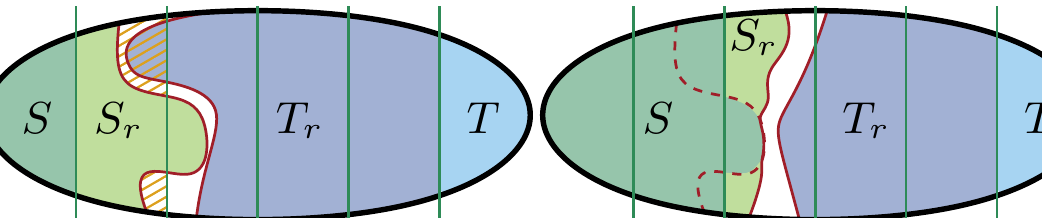
Figure 2. One piercing step of InertialFlowCutter. S in dark green, S r \ S in bright green, T in bright blue, T r \ T in dark blue. The vertical lines depict jumps in the Inertial Flow order. The cuts are depicted in red. The orange stripes in the left figure depict the piercing nodes for the source-side cut. In this case, they overlap with T r , which means that in the next iteration, the cut size increases. The right figure shows the piercing nodes settled to S as well as the newly computed cuts and S r , T r . The previous source-side cut is